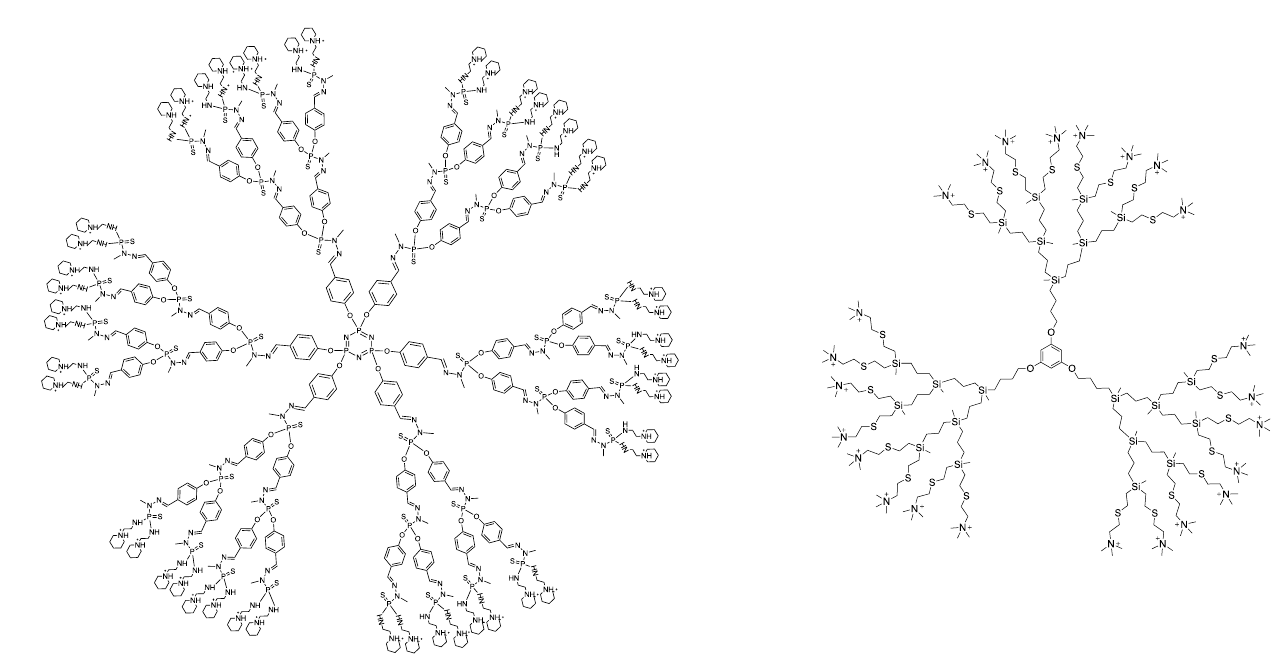
Figure 1. Molecular structures of the cationic phosphorus dendrimer AE2G3 ( left ) and carbosilane dendrimer BDEF33 ( right ) used in the study.